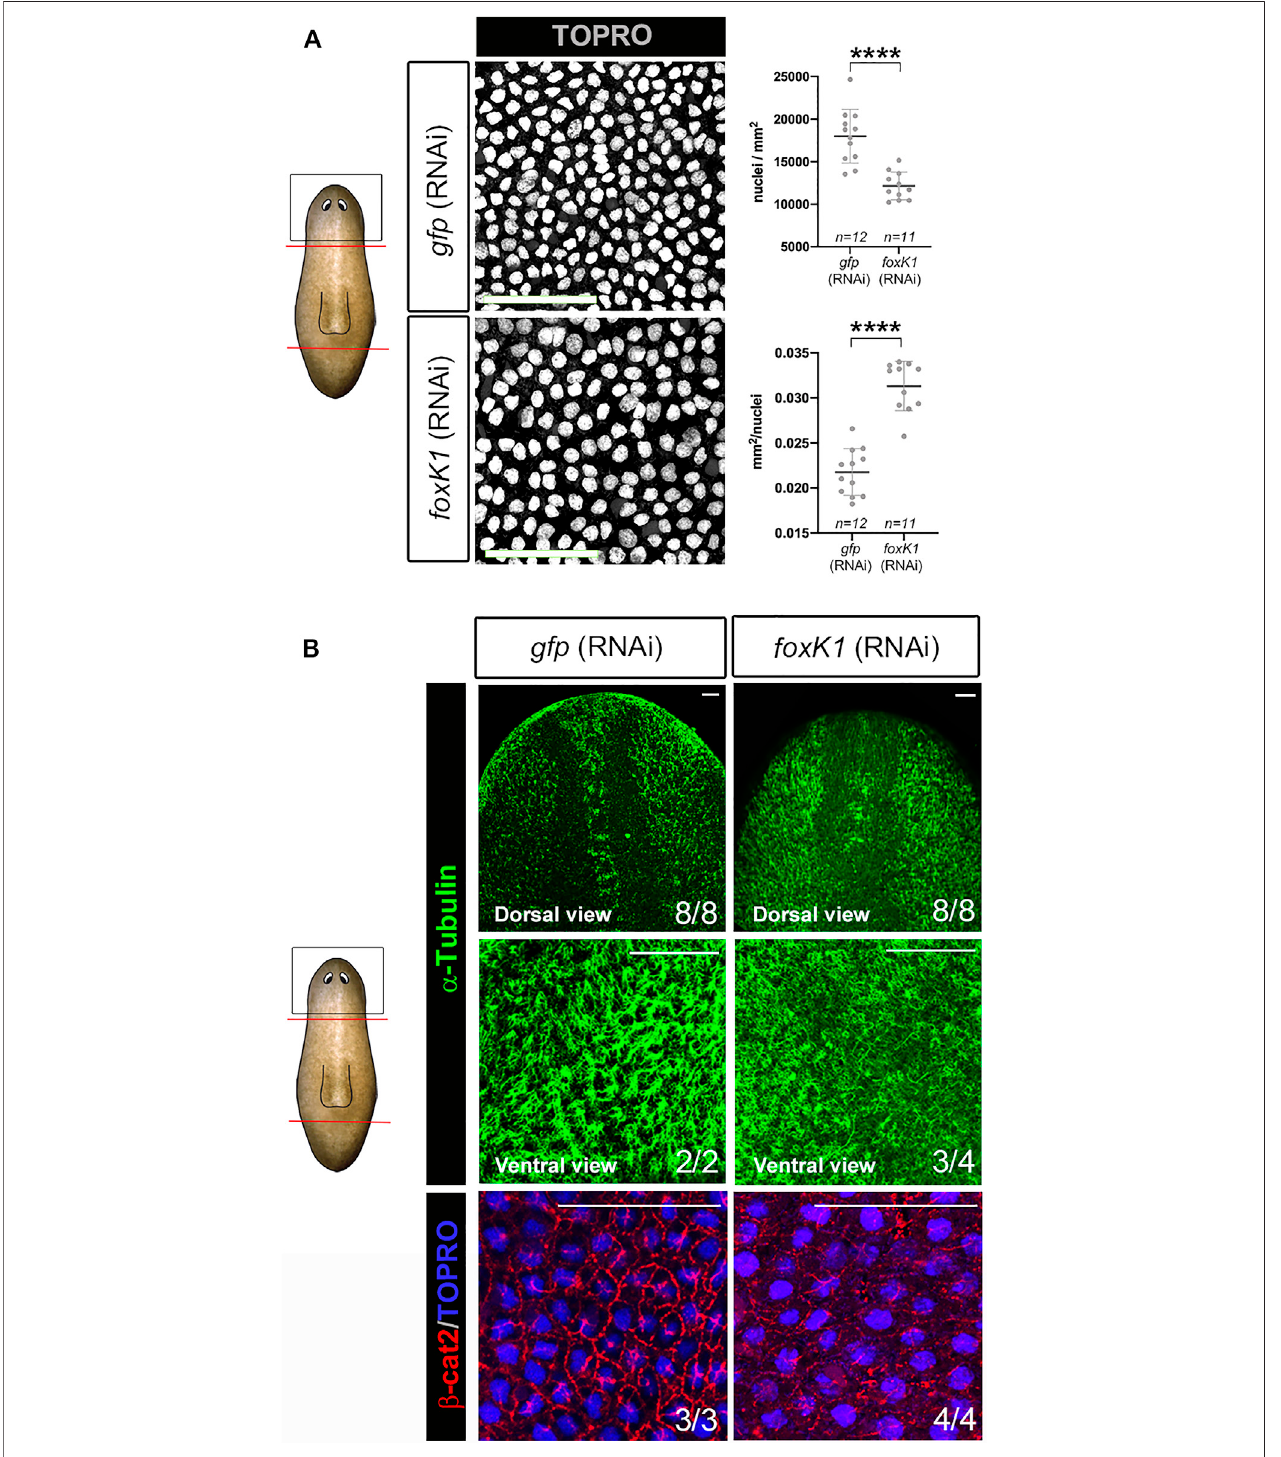
FIGURE3 | foxK1 silenced planarians show defects in theepidermis. (A) TO-PRO ® -3stainingof theepidermis inanterior wounds and quanti fi cation showing that the epidermal nuclear density decreases (number of nuclei/mm2 of the area of the confocal section) while the size for each nucleus increases (average size in mm2 of each nucleusin theconfocal section ofeveryindividual) after foxK1 silencing. Animalsat7 days ofregeneration areshown.All images aredorsal views. Valuesrepresent themean±standarddeviation[s.d]ofameanofatleast11planarianspercondition.Scalebar:50 µm**** p -value < 0.0001. (B) Immunostainingoftheepidermisin anterior wounds. Anti- α -tubulin shows the aberrant regeneration of cilia along the dorsal midline and the ventral epidermis. Merge of the immunostaining of anti- β - catenin2 and TO-PRO ® -3 in the dorsal region between the eyes showing a misorganization of the epithelial adherens junctions. Animals at 7 days of regeneration are shown. Scale bar: 50 µm. In the schematic planarians, red lines indicate the amputation planes and black squares the region analysed.